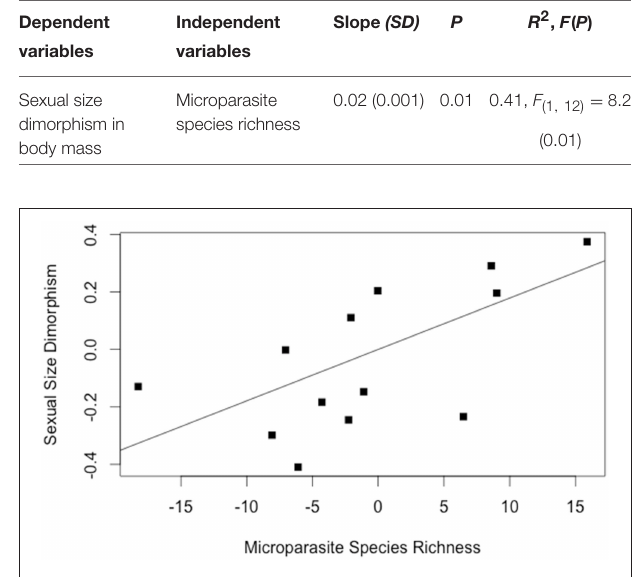
FIGURE 5 | Regression between the contrasts in sexual size dimorphism and the microparasite species richness (from the model of Table 5); ( R 2 = 0.41 , P = 0